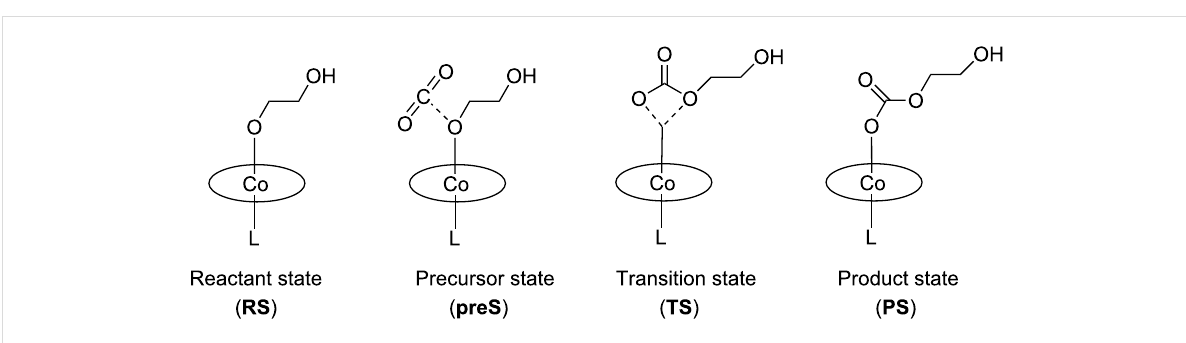
Figure 4: Carbon dioxide insertion into the cobalt(III)–alkoxide bond of [(2-hydroxyethoxy)Co III (salen)(L)] complexes.